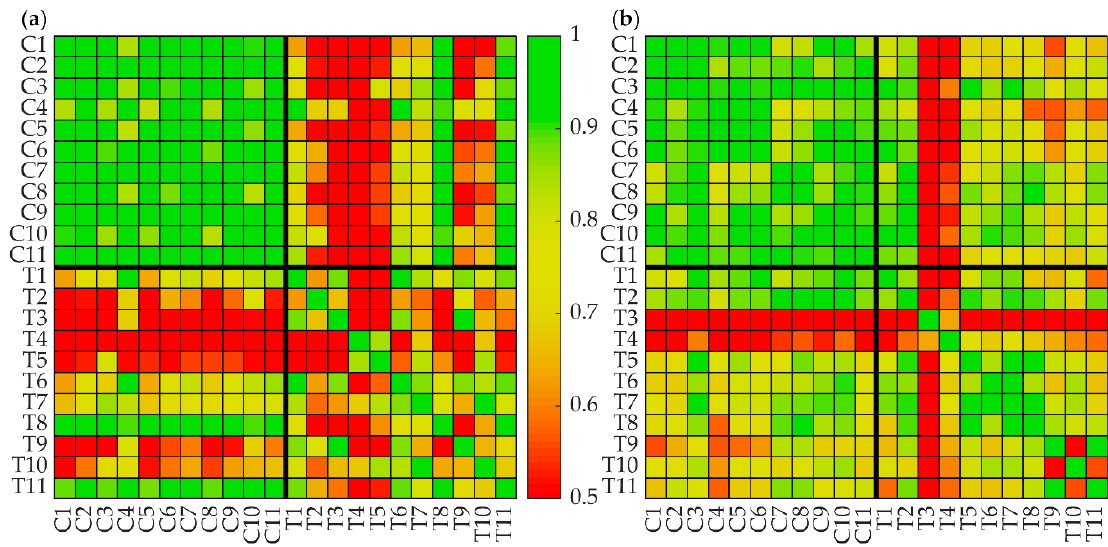
Figure 2. Heatmaps of correlation coefficients of protein intensity profiles. ( a ) Pearson’s correlation of the intensity profiles of 43 proteins included in the model, ( b ) Spearman’s correlation of the intensity profiles of 43 proteins included in the model. HCC: T1–T11, adjacent noncancerous tissue: C1–C11.